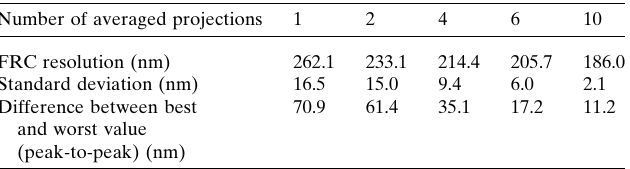
Figure 6 ( a )–( c ) Normalized (dark image and flat-field corrected) projections of the Siemens star acquired with the three different energy bandwidths in negative Zernike phase contrast mode. The black scale bar corresponds to 3 m m. The bright ring corresponds to 200 nm feature sizes, the dark ring to 100 nm feature sizes and the smallest features of the Siemens star are 50 nm. ( d ) Histograms of the above images. While the Si-111 DCM and Mo/B 4 C-MLM show a very similar behavior, the blurriness on the image for the Ru/B 4 C-MLM also shows in a reduced width of the Table 4 Calculated FRC resolution values for different numbers of averaged projections.